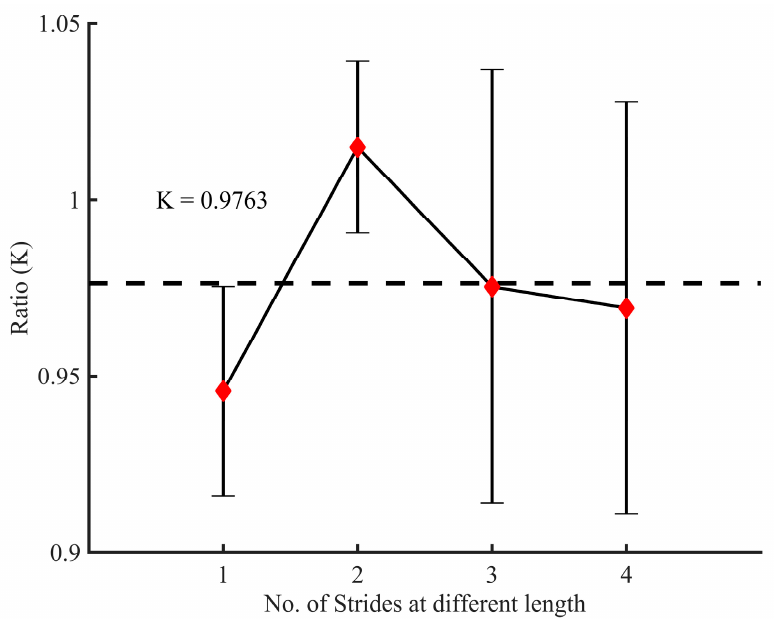
mean and the error bar. Each symmetrical error bar represents the standard deviation of fourteen tests.